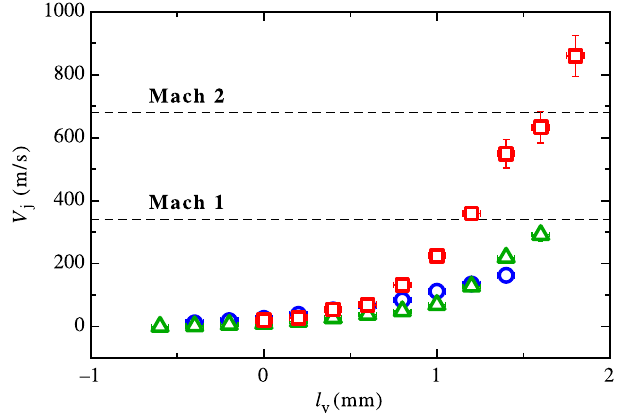
FIG. 11. Asymptotic jet velocity V as a function of the focus j offset of the laser for different capillary diameters. The circles ( (cid:7) ) represent measurements for the 500 - (cid:1) m tube; the triangles ( 4 ) refer to the 200 - (cid:1) m tube; and the squares ( h ) are for the 50 - (cid:1) m tube. Each data point is the result of at least three